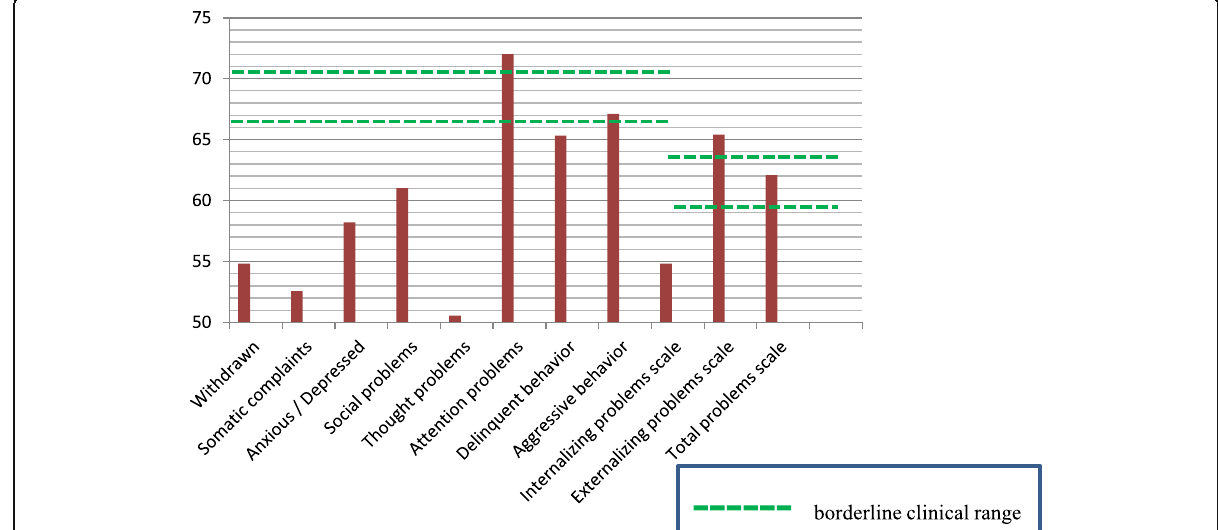
Fig. 2 Severity of behavioral problems as assessed by